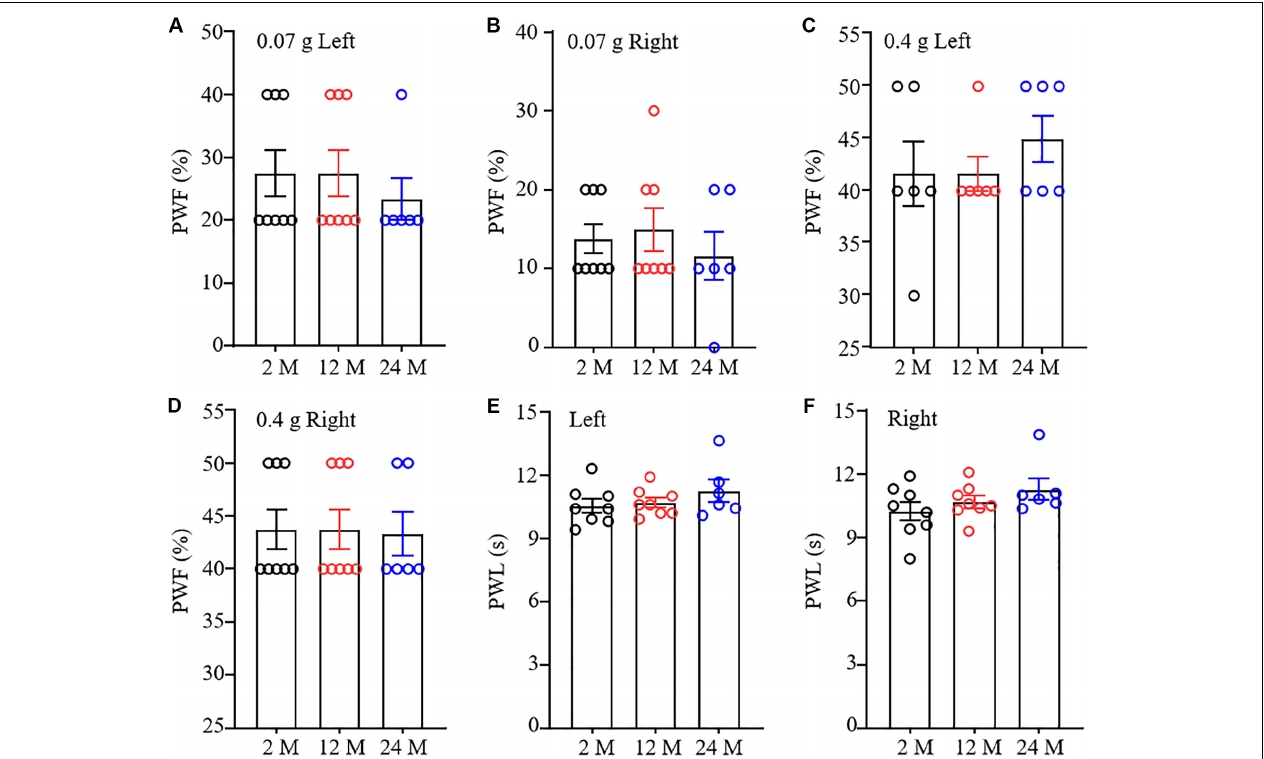
FIGURE 3 | Nociceptive response in different ages of mice. Paw withdrawal frequencies (PWF) in response to 0.07 g (A,B) and 0.4 g (C,D) von Frey filaments and paw withdrawal latency (PWL) on response to heat stimulation (E,F) on the left (A,C,E) and right (B,D,F) sides. n = 8 for 2- or 12-month mice, n = 6 for 24-month mice. Data were shown as mean ± SEM. One-way ANOVA with repeated measures followed by post hoc Tukey